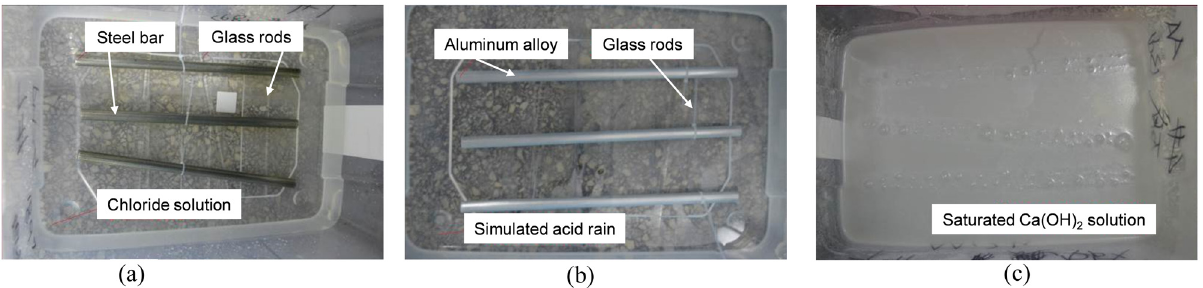
Figure 2: Corrosion test in di ff erent simulated environments: ( a ) chloride solution, ( b ) simulated acid rain, and ( c ) saturated Ca ( OH ) 2 solution.